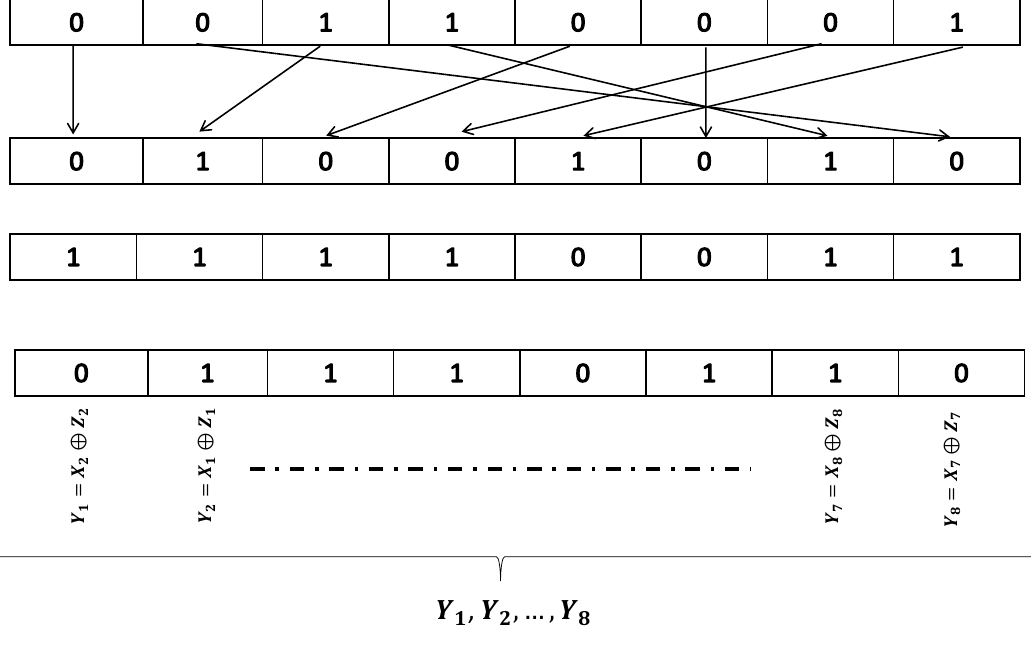
Figure 2. Cro ( . ) security